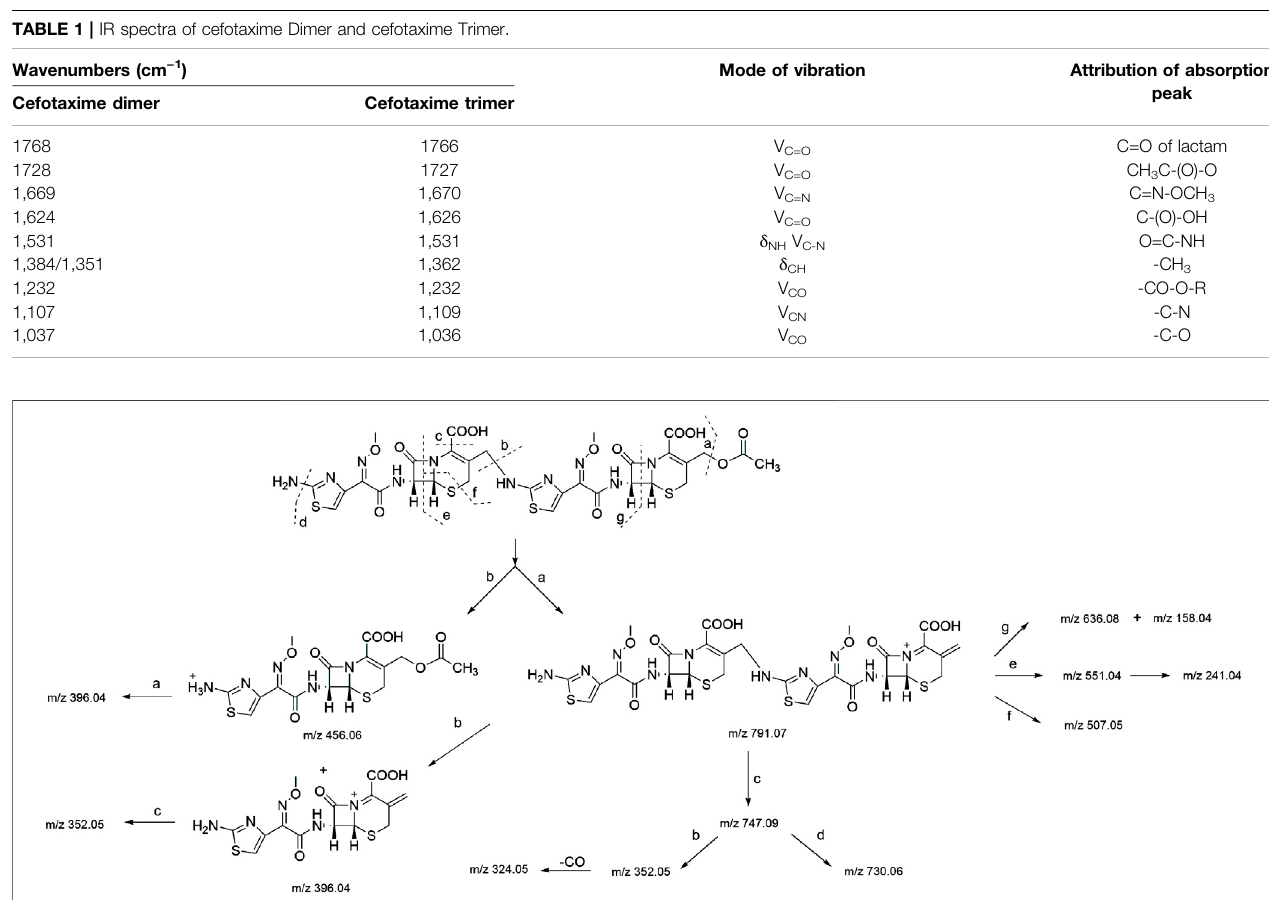
FIGURE 3 | MS fragmentation pathway of cefotaxime